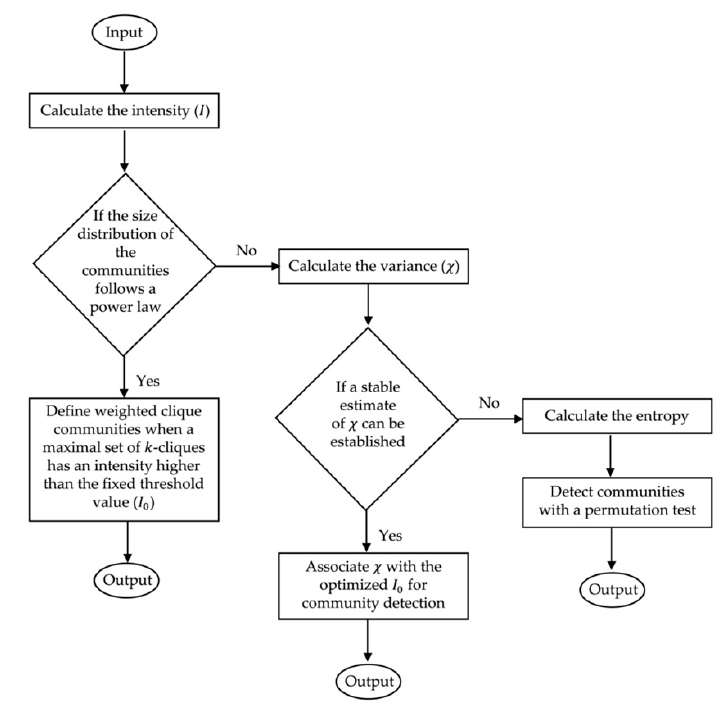
Figure 1. Research methodology flow